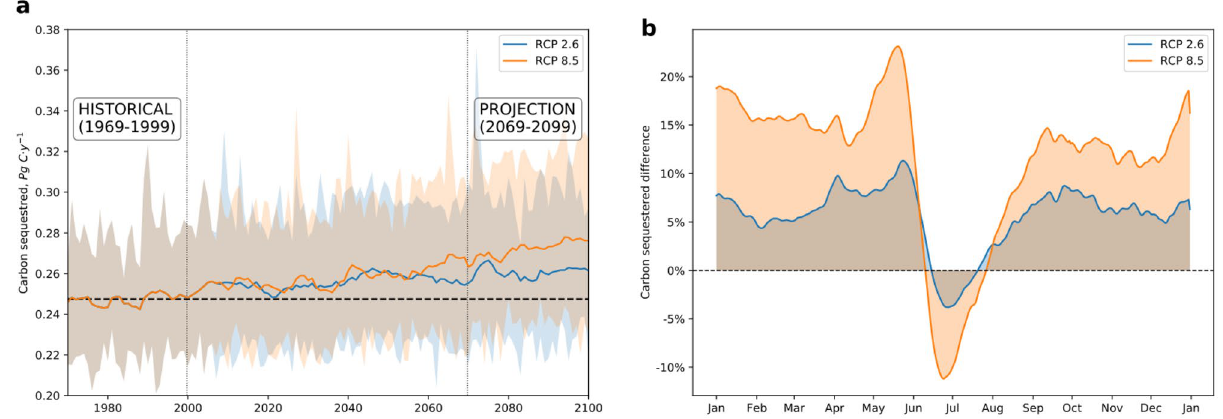
Figure 1. Temporal evolution of the global soil CO 2 sequestered for the RCP 2.6 (blue) and RCP 8.5 (orange) scenario: (a) interannual fluctuations in annual weathering CO 2 consumption, where shaded areas represent the minimum and maximum amount of annual carbon sequestered in five general circulation models, and the solid lines account for a 10-year moving average to evaluate the pattern. The dashed horizontal line represents the mean consumption for the Historical period. (b) Seasonal variations for the daily mean relative difference between the Projection (ECP) and Historical